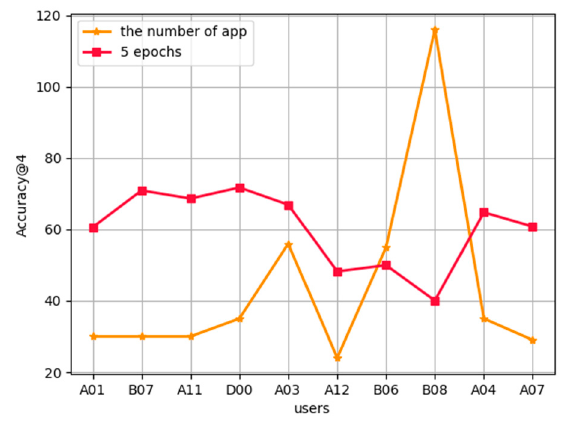
Figure 7. Effected of the number of used applications on FL-AHNEAP.